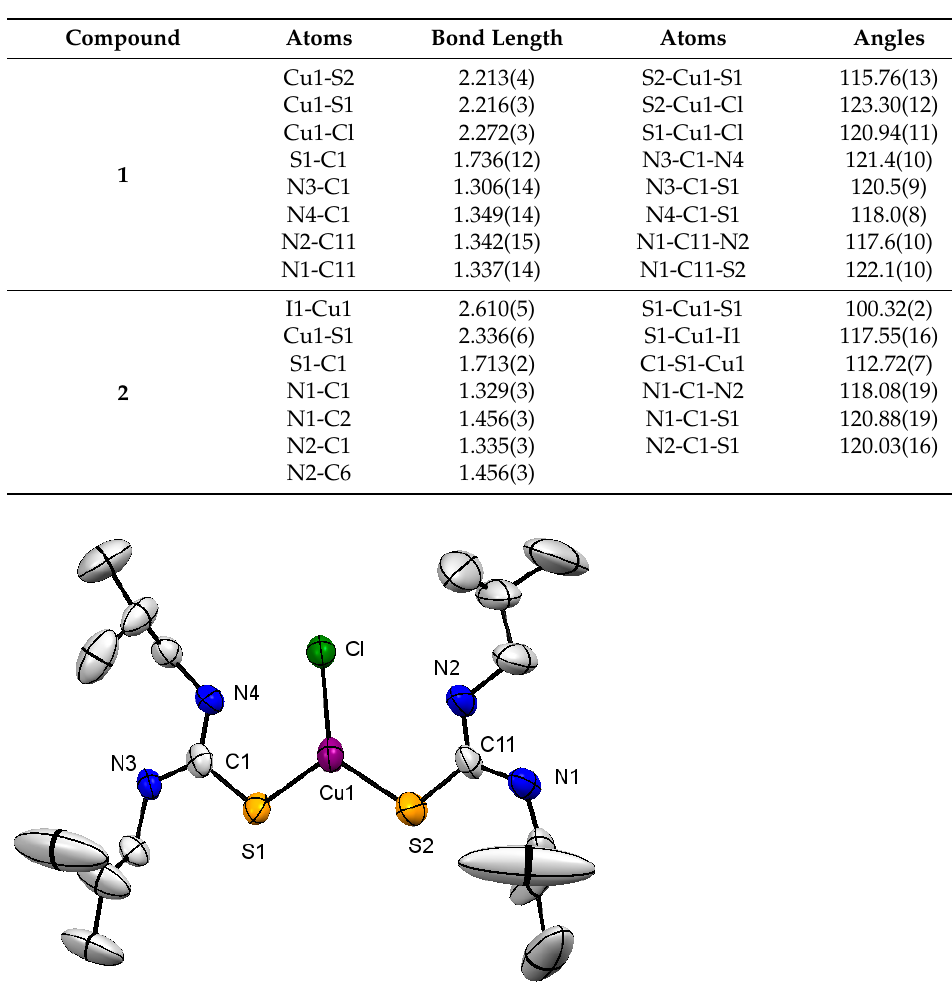
Table 2. Selected bond lengths (Å) and angles ( ◦ ) of structures 1 and 2 .